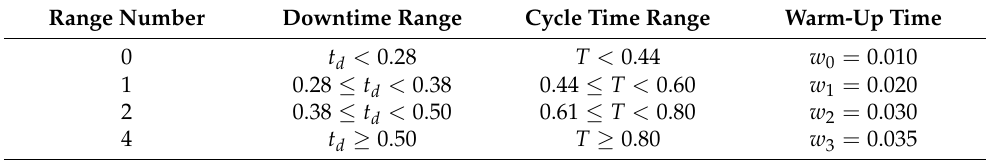
Table 6. Warm-up time diagram based on the downtime range with a rework